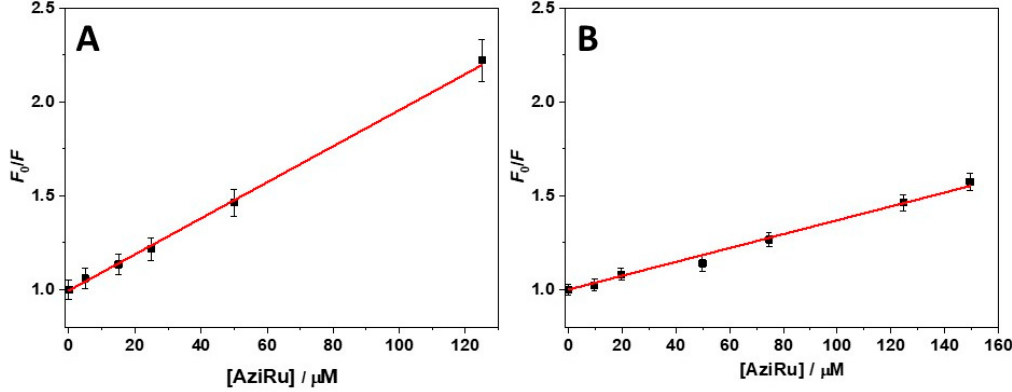
Figure 2. Stern–Volmer plots for the binding of AziRu with ( A ) HSA and ( B ) hTf at 20 °C. The red lines represent the best fit of experimental data according to equation 1 reported in the text.